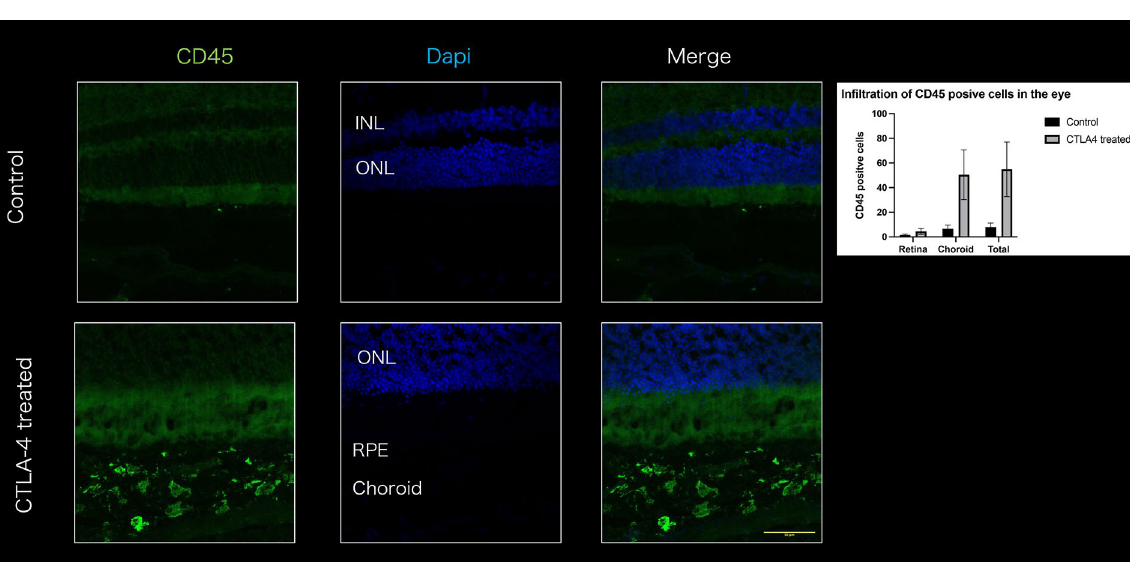
Figure 7. CD45 staining in control and anti-CTLA4-treated eyes (n = 7 in each group). Choroidal infiltration of round or ameboid-like CD45-positive cells was observed in treated eyes. There was a significant difference in the number of CD45-positive cells in the choroid between control and treated eyes. On the other hand, very limited CD45-positive staining was observed in the retina. RPE: retinal pigment epithelium, ONL: Outer nuclear layer, INL: Inner nuclear